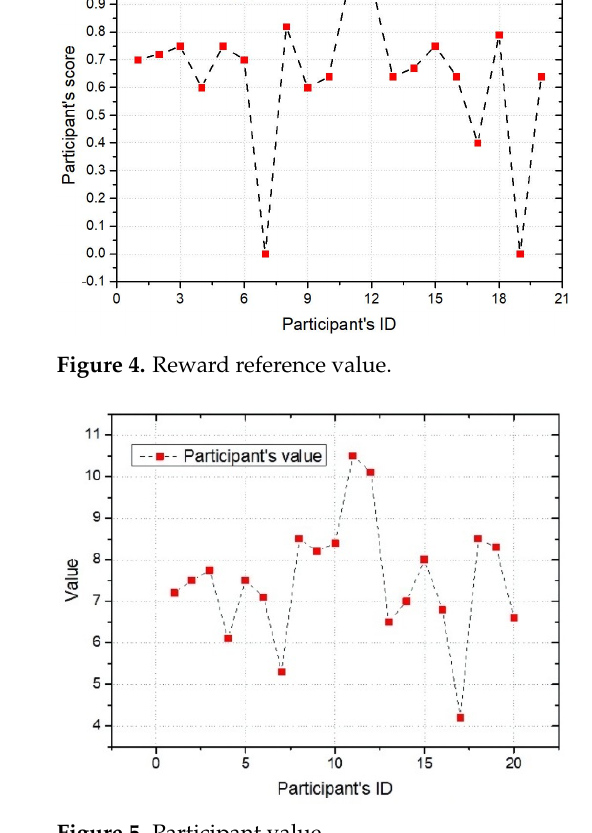
Figure 6. Participant value analysis.